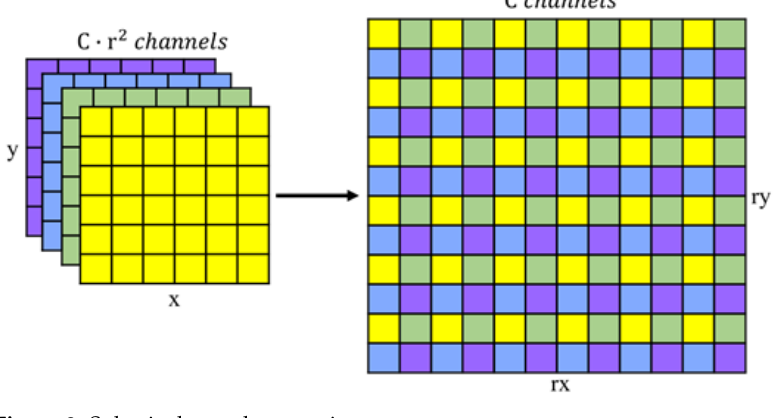
Figure 3. Sub-pixel sample operation.